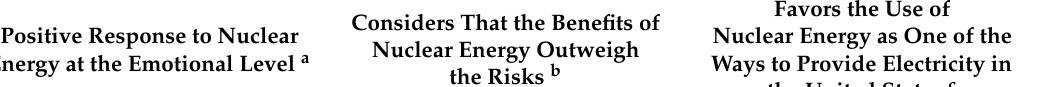
Table 2. Logistic regression results showing the association of geographical location and socio- demographics with nuclear energy perceptions (n =